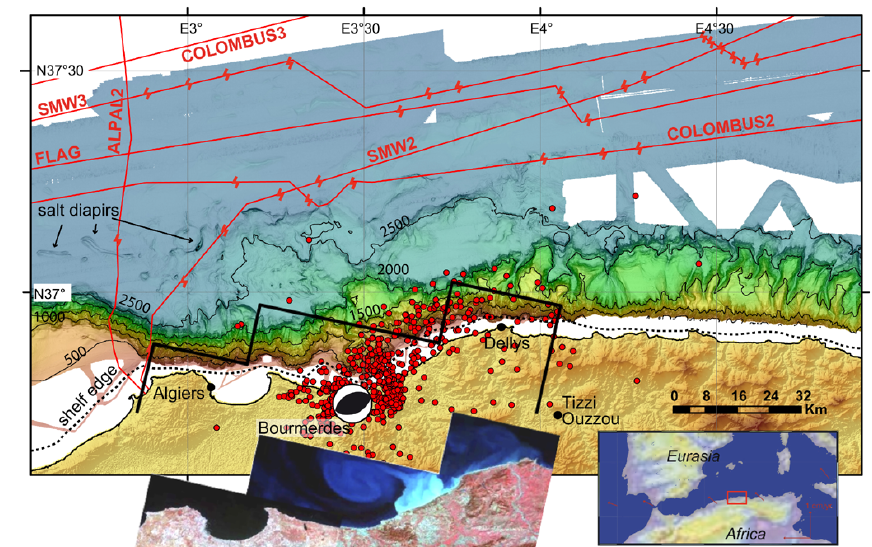
Fig. 1. Bathymetric map of the central Algerian margin with the layout of six offshore telecommunication cables and the location of cable breaks that occurred after the 2003 Boumerd`es earthquake (red symbols). The epicenter of the M 6.8 2003 Boumerd`es earthquake is repre- sented by its focal mechanism, while red circles represent the location of the associated aftershocks. The interval of bathymetric contour is 500m. The location of the shelf edge is derived from navigation maps as reported in Cattaneo et al. (2010). The inset shows a Landsat image of the sediment plume off Boumerd`es that originated after the